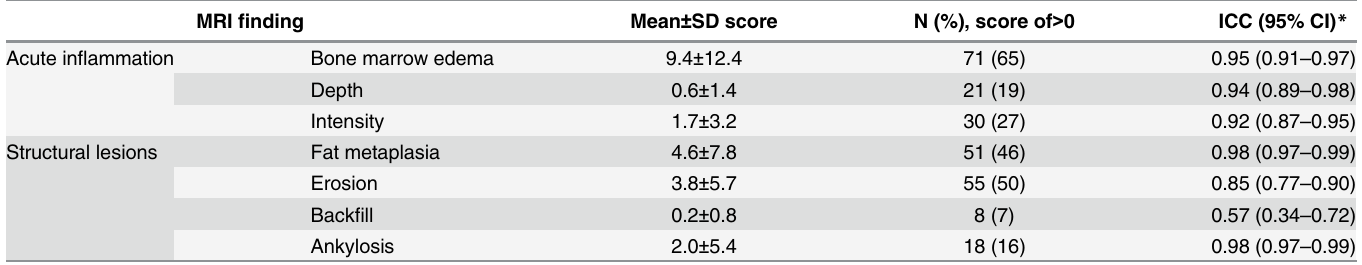
Table 2. Baseline sacroiliac joint MRI findings in patients with axial spondyloarthritis (n =